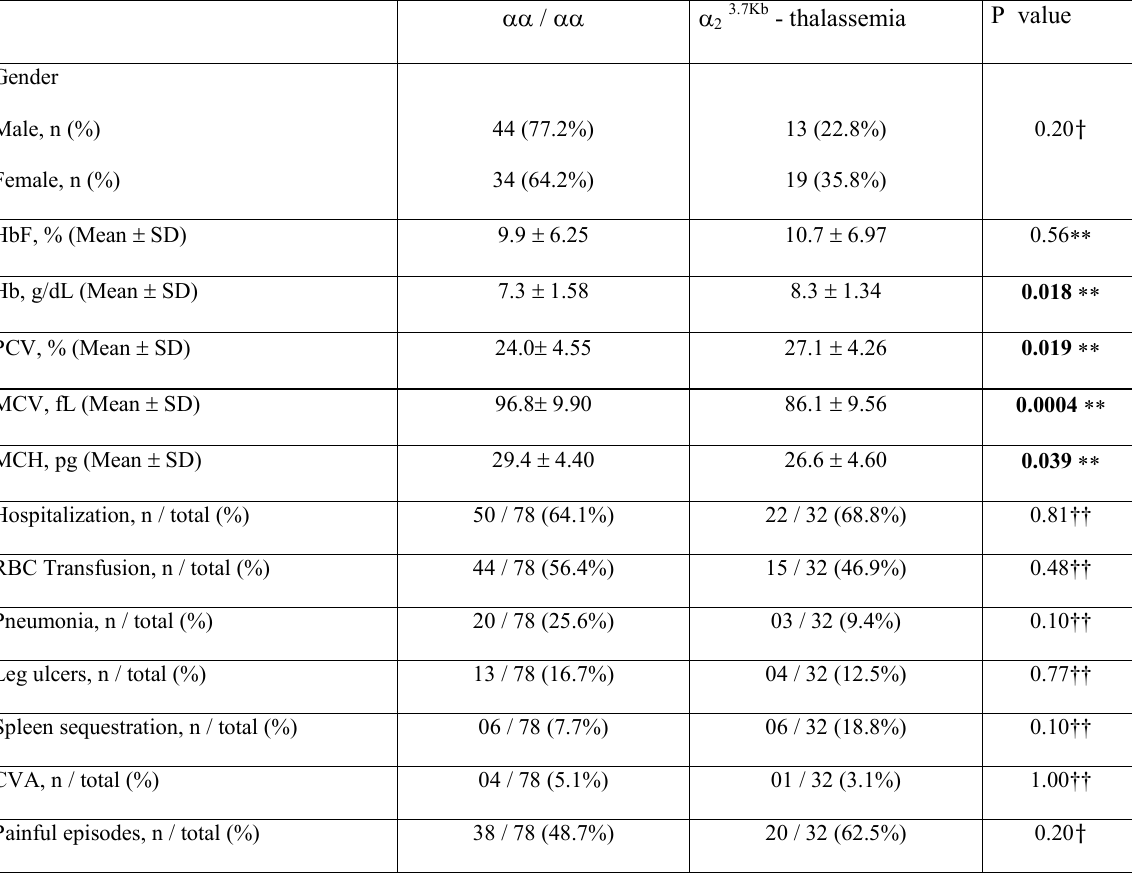
Gender, hematological and phenotypic characteristics among sickle cell anemia patients from Bahia, Brazil, with different α - genes genotype. Significant results of statistical tests (at the 5% level) are shown in bold face